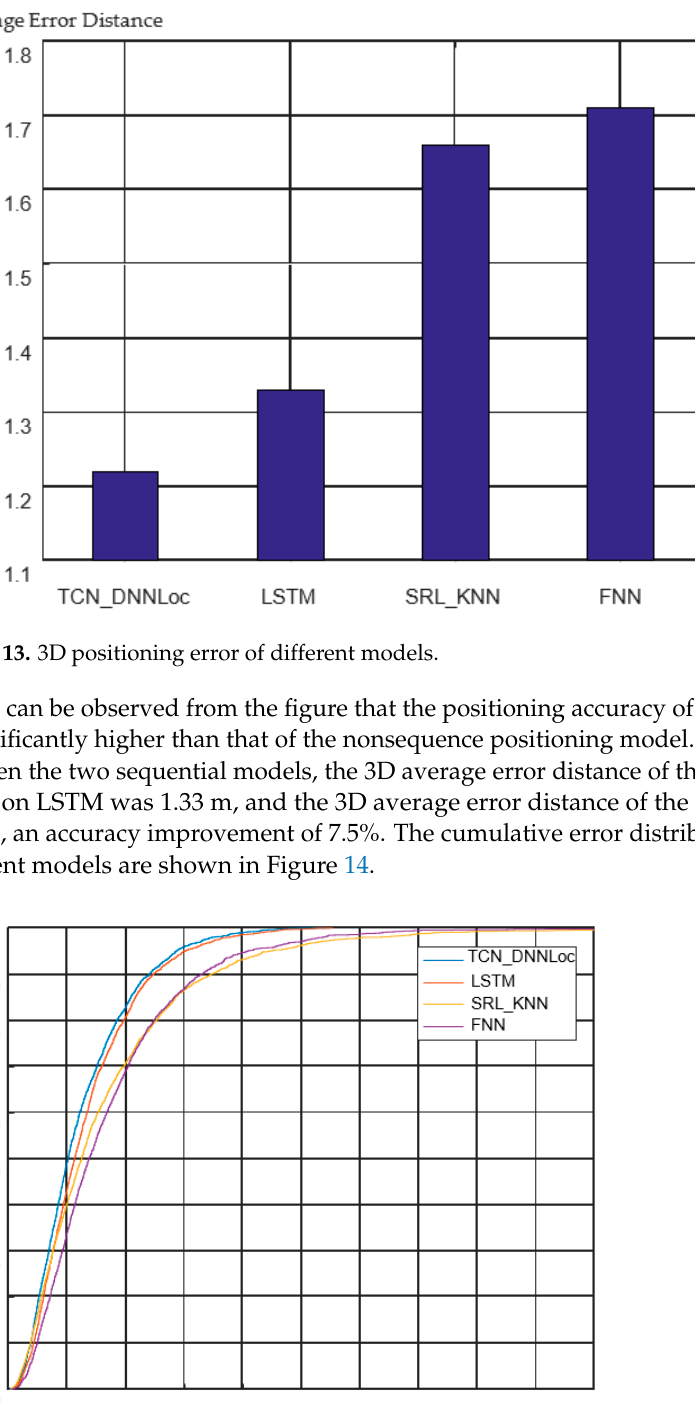
Figure 14. Cumulative distribution functions for different models.